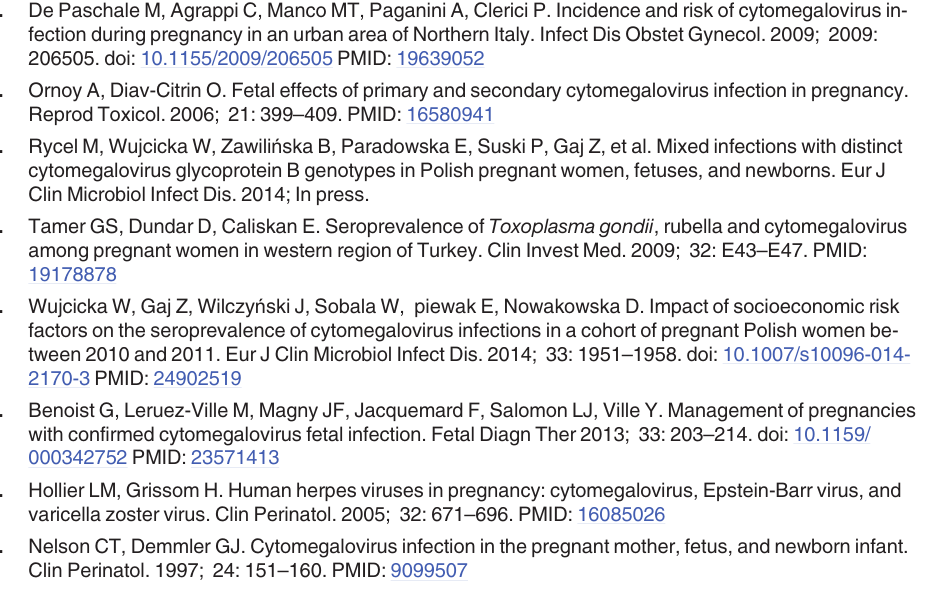
S1 Table. Single-SNP analysis of the relationship between TLR polymorphisms and cytome- galy outcome. a n, number of tested fetuses and newborns; b OR, odds ratio; c 95% CI, confi- dence interval; d logistic regression model; P (cid:1) 0.050 is considered as significant; e NA, not analyzed